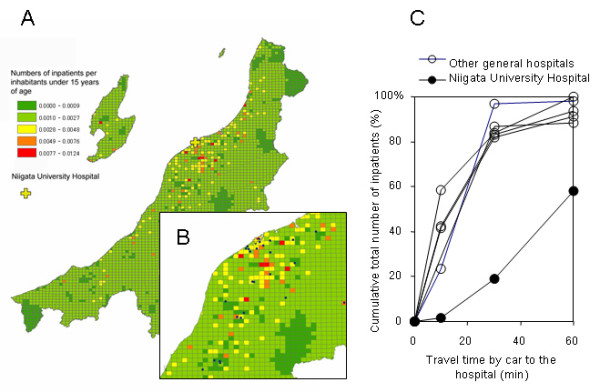
Medical service area for inpatients. (A) Empirical Bayesian estimates for the rate of inpatients per childhood population at risk were plotted on a map with 2 km mesh. (B) Magnification of (A). (C) The relationship between travel time by car from Niigata University Hospital (closed circle) or five other hospitals (open circles) in Niigata City and the number of inpatients covered within each area.